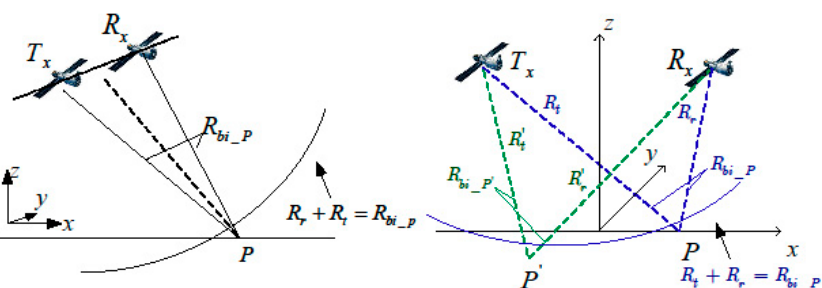
Figure 3. The illustration of the spherical and ellipsoid surface of the backward bistatic and forward bistatic.